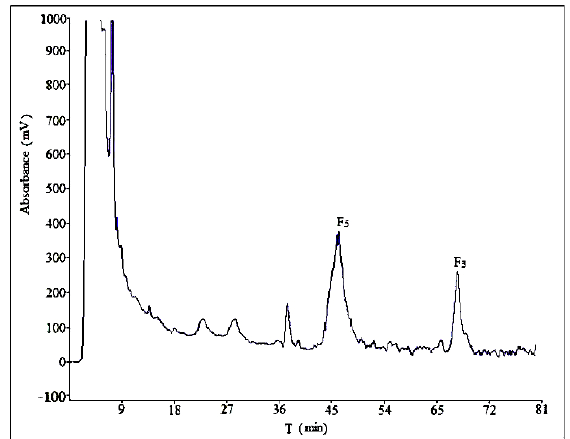
Figure 5. The semi-preparative chromatogram of CEFBPG with the mobile phase of methanol:water (58:42) at room temperature and a flow rate of 10 mL/min.